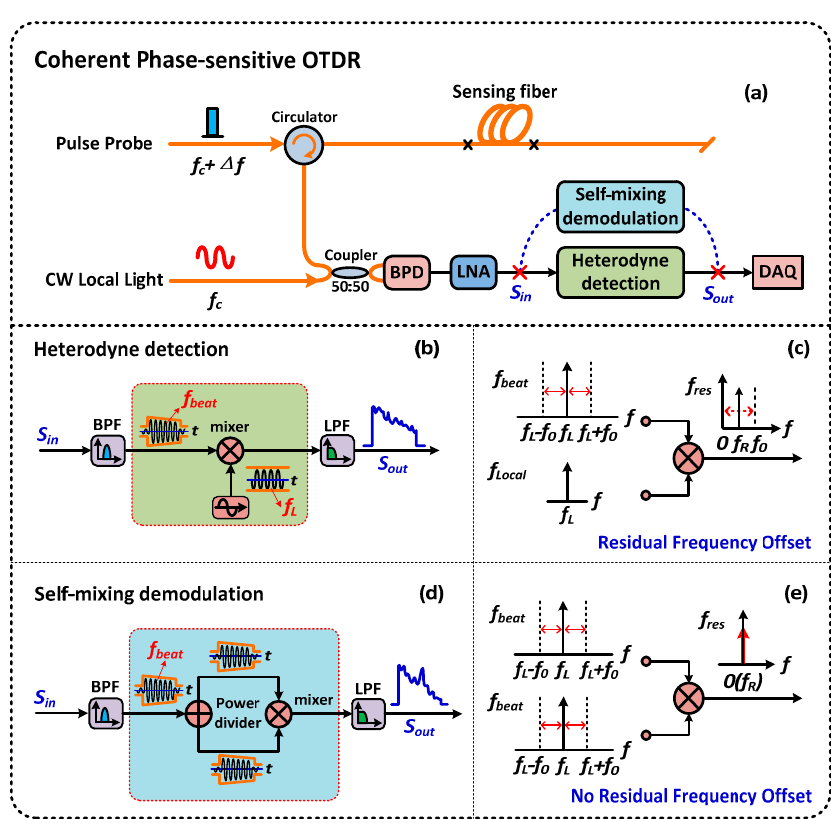
Figure 2. The principle comparison between the self-mixing and the heterodyne demodulation method. ( a ) The schematic diagram of the coherent phase-sensitive OTDR system based on self-mixing demodulation and heterodyne detection; BPD: Balanced photo detector; LNA: Low noise amplifier; BPF: Bandpass filter; LPF: Low-pass filter; DAQ: Data acquisition card; ( b ) The schematic diagram and ( c ) the demodulated result of the heterodyne detection; ( d ) The schematic diagram and ( e ) the demodulated result of the self-mixing demodulation.